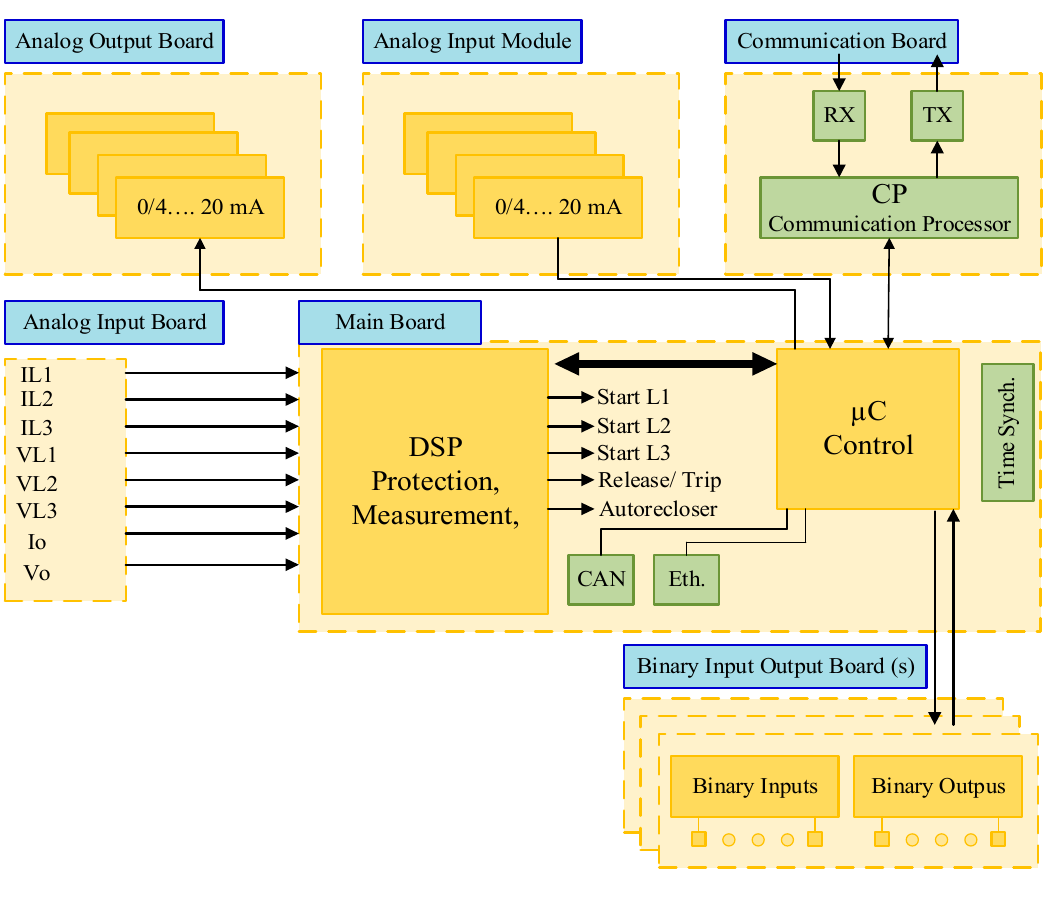
Figure 1. The block diagram of REF 542 plus.